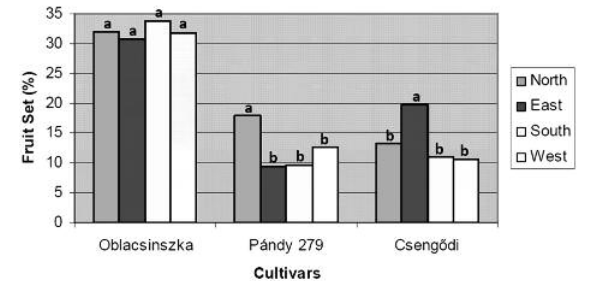
Figure 2C. Fruit set of sour cherry cultivars on different direction of the tree